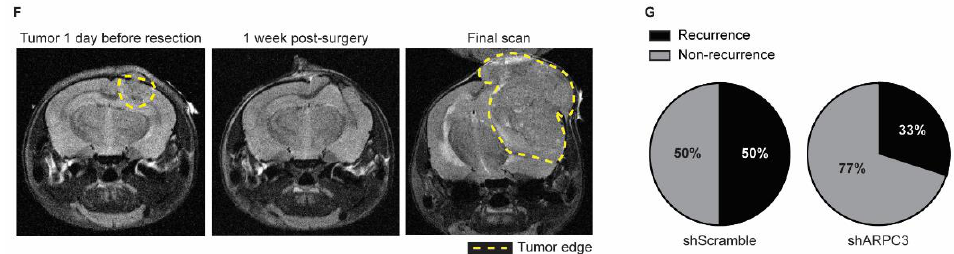
Figure 4. Impeding tumor cells migration improves surgical resection. ( A ) Schematic representation of experimental design. ( B ) Quantification of the tumor volume in mice intracranially injected with BCBM organoids engineered with the shScramble ( n = 8) and shARPC3 ( n = 6) constructs, one day before resection and as measured by MRI. Data are presented as mean +/ − SEM; p -value was determined using a Mann–Whitney t -test, two-tailed. ( C ) Time between intracranial injection and resection for mice injected with BCBM organoids engineered with the shScramble ( n = 8) and shARPC3 ( n = 6) constructs. Data are presented as mean +/ − SEM; p -value was determined using a Mann–Whitney t -test, two-tailed. ( D ) Representative images and ( E ) quantification of the percentage of tumor area (green fluorescent signal of H2B-Dendra2 expressed by all BCBM cells) left after resection. Each square represents one mouse. ( F ) Representative MRI images of a mouse brain at the various stages of the experiment. ( G ) Pie charts showing the percentage of mice that recurred until 11 weeks after resection. Additionally, see Figure S2.